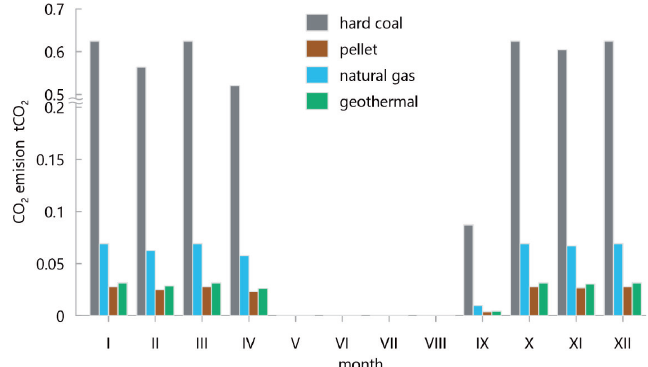
Figure 9. CO 2 emission from different fuels combustion on a monthly